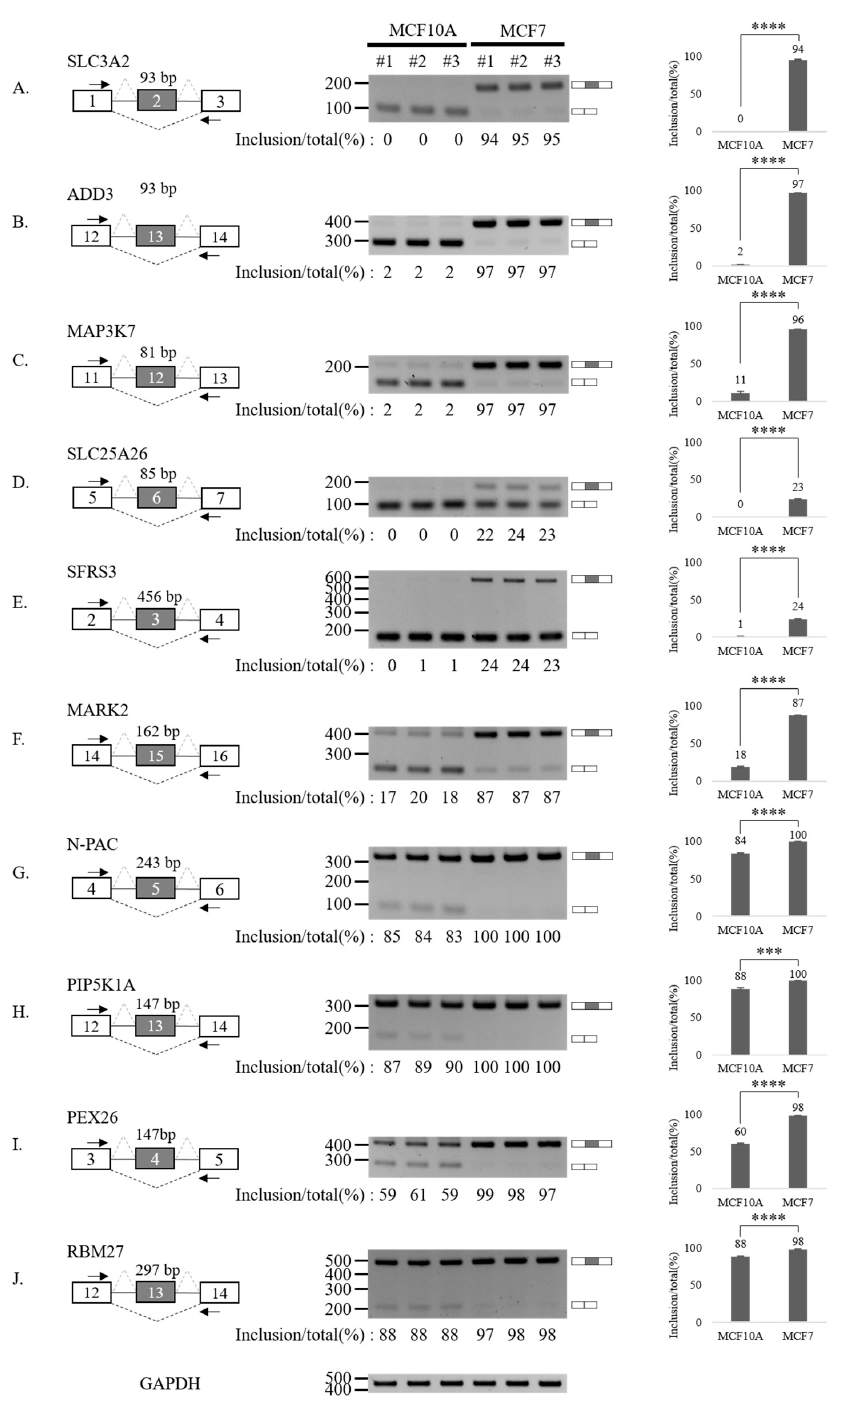
Figure 3. Validation of AS up-regulated cassette exons in human breast cancer cells. ( A – J ) (Left) For each gene, the schematic representation of the genomic region containing the AS cassette exon is shown. Exon numbers are shown in the gray boxes. The length of AS cassette exons is shown. Inclusions of cassette exons are shown with dotted grey lines. Skipping events are shown with dotted black lines. Arrows indicate primers used in RT-PCR. (Middle) RT-PCR analysis (in triplicated) of the AS profile of cassette exons was performed by using RNA extracted from human breast cells. Quantitation results are shown at the bottom of each gel. (Right) Statistical analysis graphs of RT-PCR. Error bars = standard deviation (SD) calculated from three independent experiments. **** p < 0.0001, *** p < 0.001. Uncropped figures are shown in Supplementary Figure